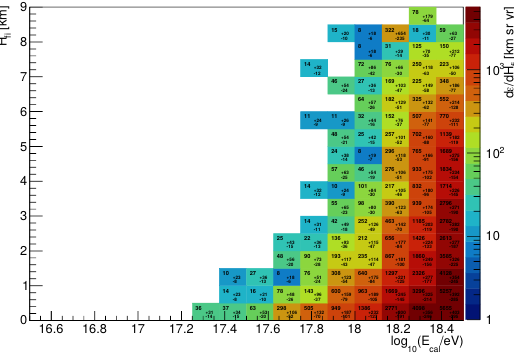
Figure 5. The double-di ff erential exposure of the FD to UG EASs. An isotropic emergence of events for θ ∈ [110 ◦ , 180 ◦ ] is assumed.